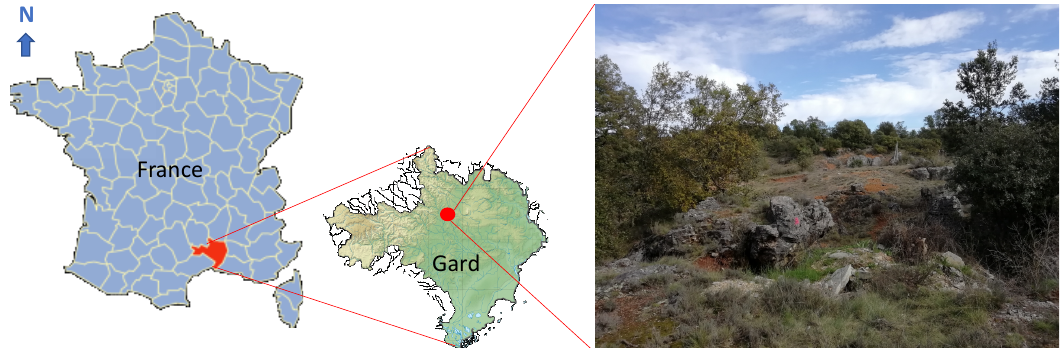
Figure 1. Site location in Gard (France) nearby Rousson and a view of the spontaneous vegetation at the abandoned mine site (March 2020).